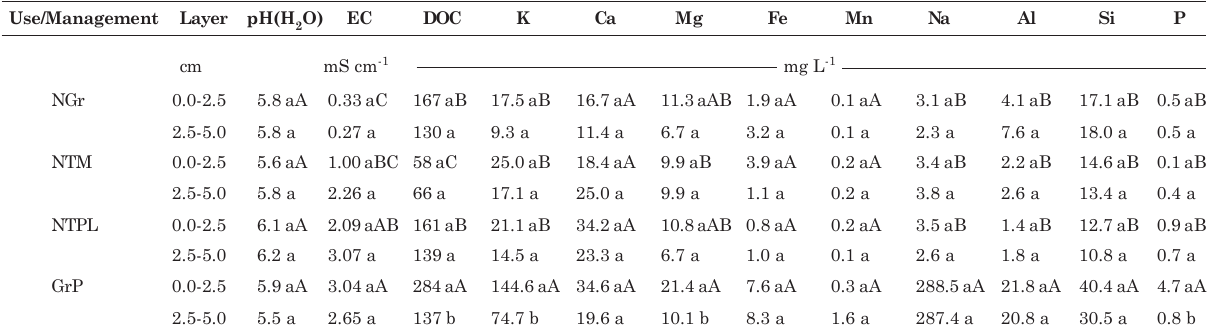
Table 4. Chemical properties of the soil solution in two layers of a Rhodic Paleudult under four land use and management